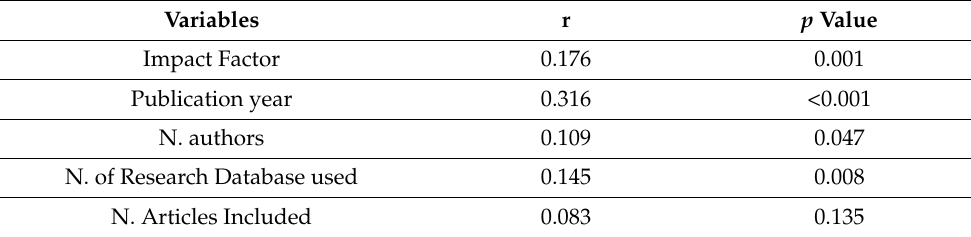
Table 3. Pearson’s correlation analysis of AMSTAR-2 score vs. quantitative variables.